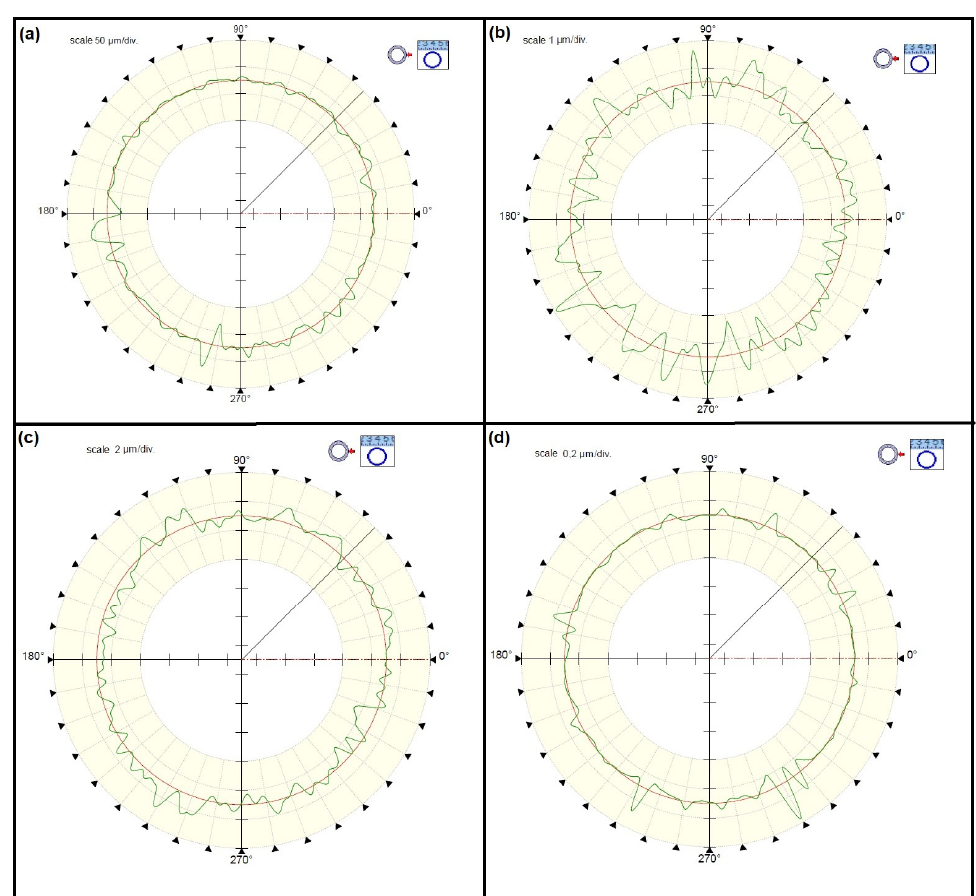
Figure 4. The waviness profiles of the inner ring races after the following stages of machining ( a ) forging, ( b ) turning, ( c ) heat treatment, ( d ) grinding.